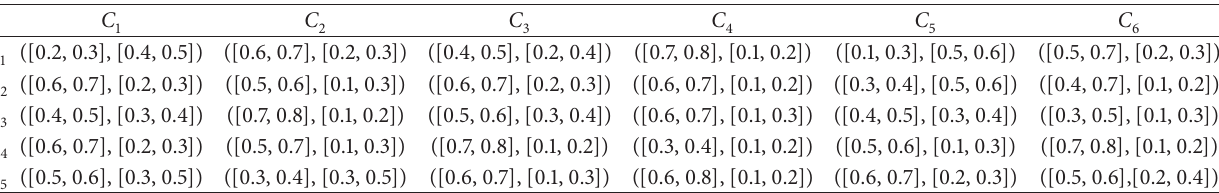
Table 2: Decision matrix 𝐷 5×6 ( 𝑥 𝑖𝑗